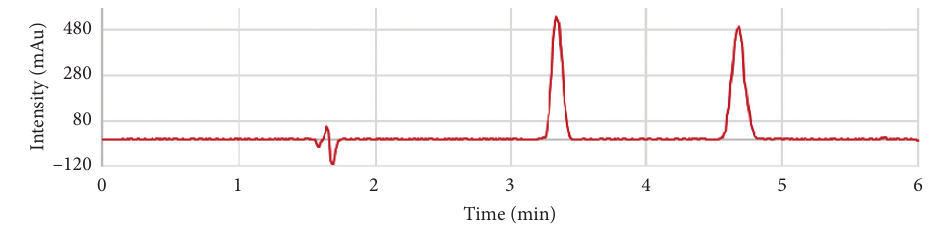
Figure 2: HPLC separation of Sudan dyes I and II. Table 2: Method performance and validation